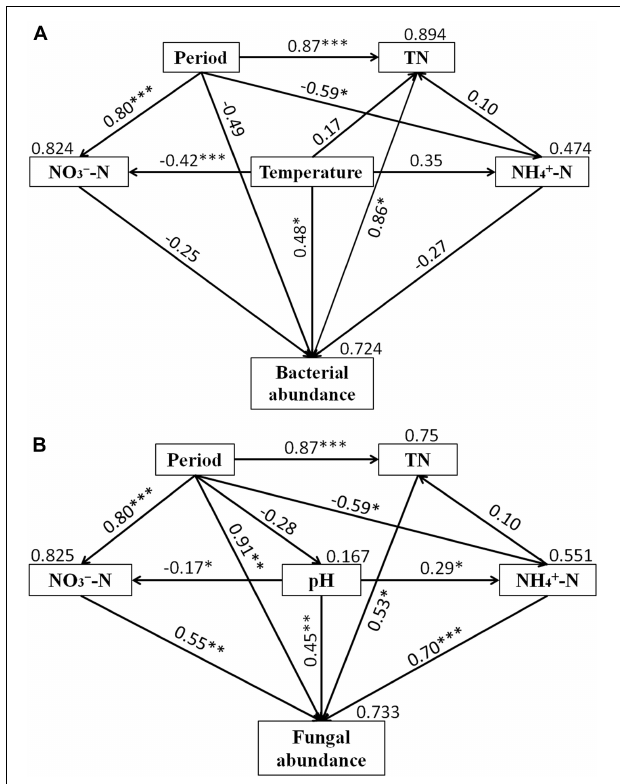
FIGURE 6 | Structural equation models (SEMs) showing the effects of period, NH 4 + -N, NO 3 − -N, TN, temperature and pH on bacterial (A) and fungal (B) abundance. Values on the arrows represent the path coefficients. Values on the text box represent the proportion of variance explained for each variable. Lines with ∗ indicate significant pathways ( ∗∗∗ P < 0.001; ∗∗ P < 0.01; ∗ P < 0.05).